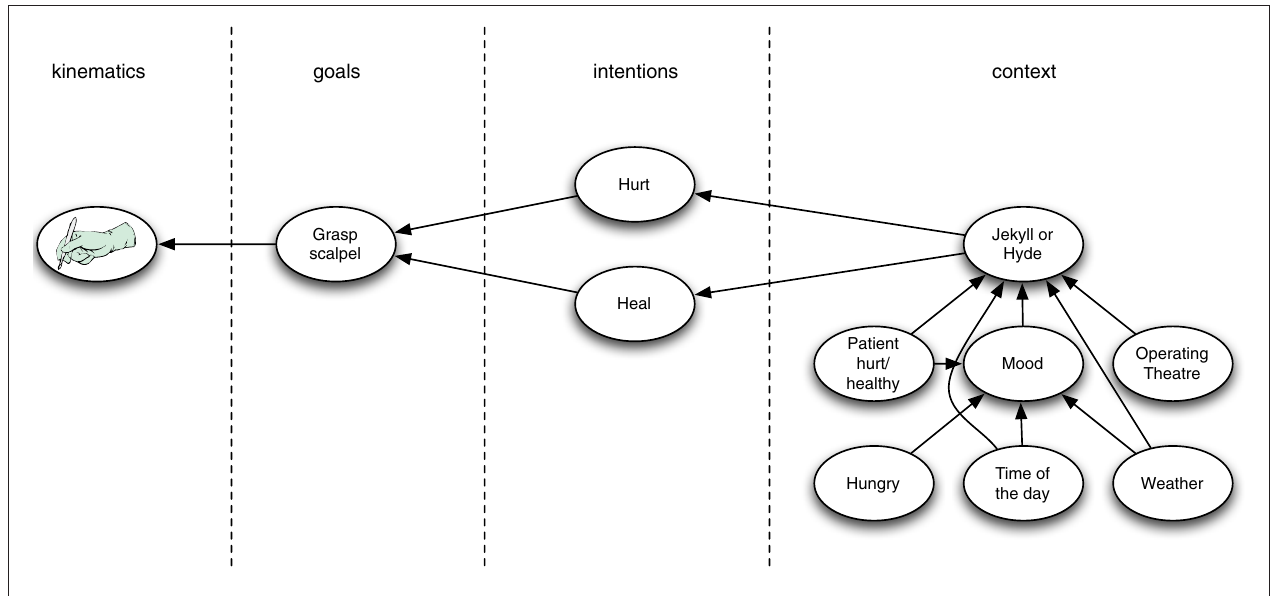
Figure 1 | An illustration of a hierarchy with higher level complex causal models. The illustration builds on the Jekyll and Hyde example used by Kilner et al. (2007). Kilner et al. assumed four different levels and simple mappings between the levels. For example, if at the higher level one infers that the person grasping the scalpel is Dr. Jekyll (or Mr. Hyde) then at the lower level one predicts the intention is to heal (or to hurt). The Figure illustrates that at higher levels of the hierarchy the causal models within a level can become quite complex. Whether one infers that the person is Jekyll or Hyde can